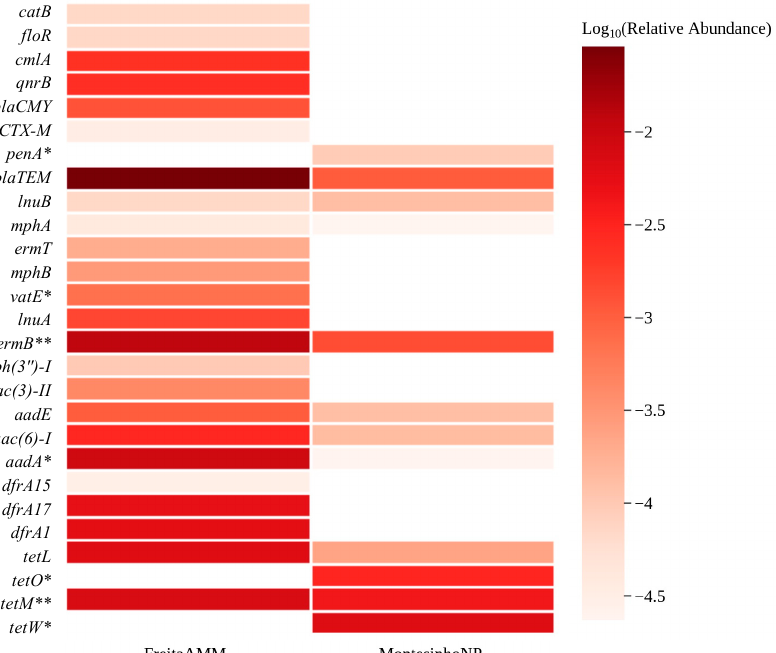
Figure 4. The relative abundance of high-risk ARGs (Rank I and Rank II) identified in this study are shown in the heatmap. * marks ARGs from Rank II, and ** marks ARGs belonging to both ranks.